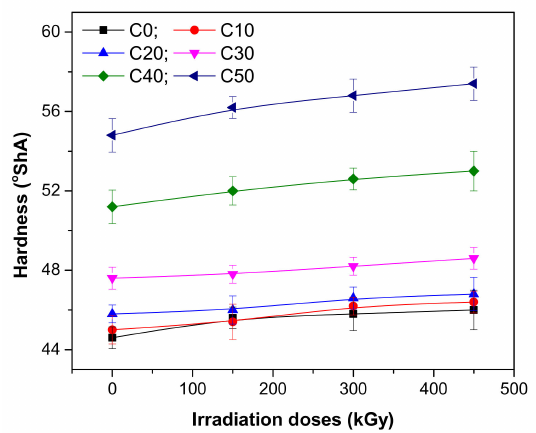
Figure 1. Hardness variation as a function of EB irradiation dose and PS amount.